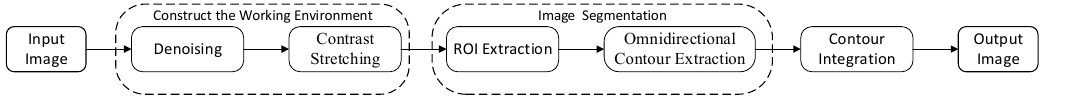
Figure 1. The flowchart of the algorithm.